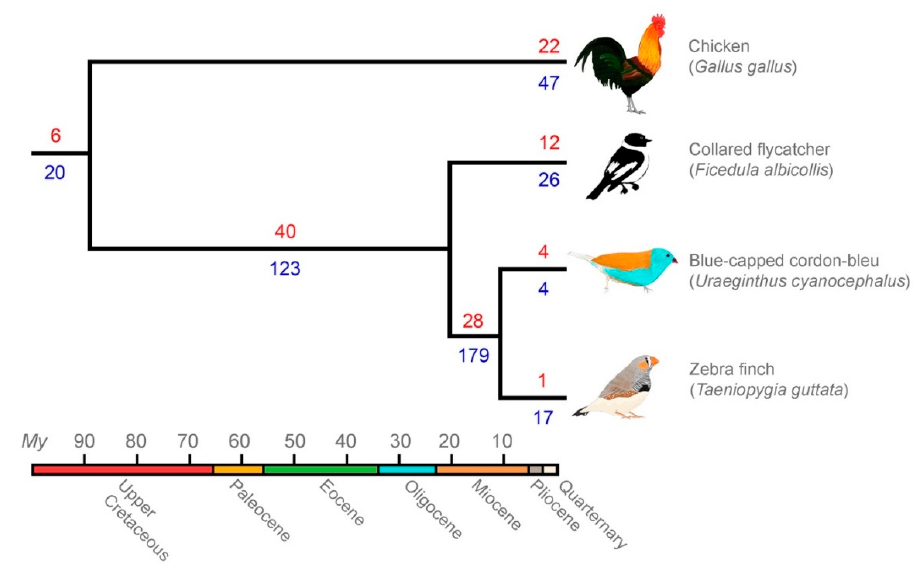
Figure 3. Analysis of LTR diversity along branches in the tree of birds with in-depth curated TE libraries. The number of LTR families and subfamilies on each branch are depicted in red (above branches) and blue (below branches), respectively. Most LTR retrotransposon families are shared between blue-capped cordon-bleu and zebra finch. The previously thoroughly investigated genome of zebra finch contains more lineage-specific TE subfamilies. A large diversity of LTR families and subfamilies are shared among the three songbirds compared with the relative sparse number of LTRs shared with chicken at the root of the tree. Node estimates are based on previously published timetrees